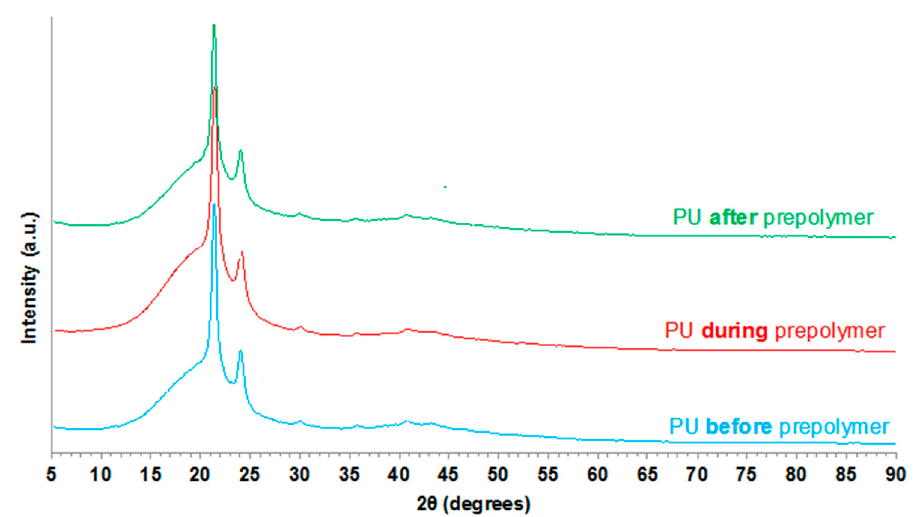
Figure 11. X-ray diffractograms of the PU films.